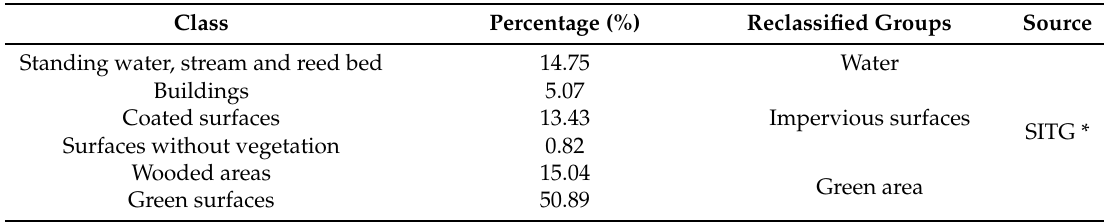
Table 1. Land cover classification in